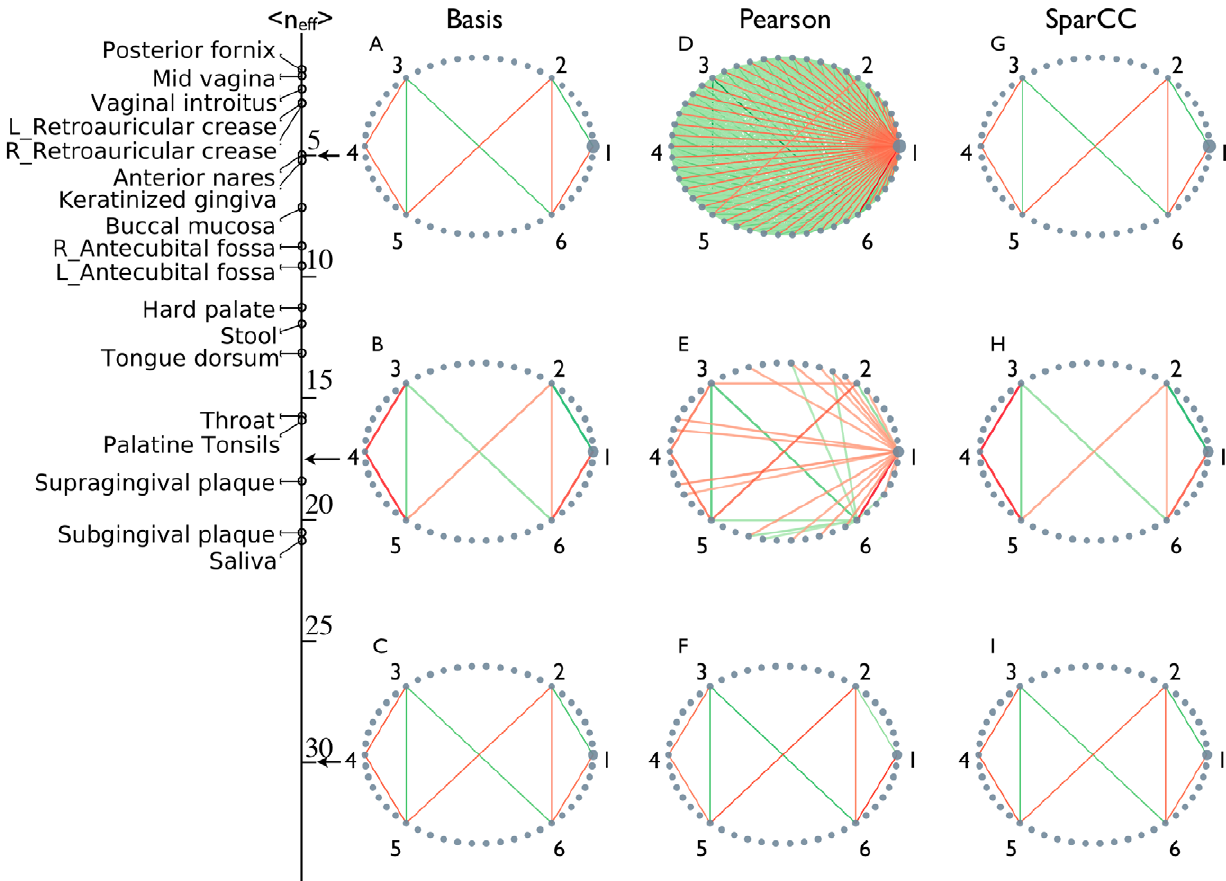
Figure 2. Pearson correlations inference quality deteriorates with decreasing diversity. Basis data was simulated with a known correlation structure. OTU counts were generated by randomly drawing from the basis, and were subsequently subject to both correlation inference procedures. (A–C) True basis correlation network. (D–F) Networks inferred using standard procedure. (G–I) Networks inferred using SparCC. The average community diversities, as given by the Shannon entropy effective number of components n eff , used in the simulations and observed in the HMP data are indicated on left indicates. As in Fig. 1, nodes represent OTUs, with size reflecting the OTU’s average fraction in the community. Nodes represent OTUs, with size reflecting the OTU’s average fraction in the community. Edges between nodes represent correlations between the nodes they connect, with edge width and shade indicating the correlation magnitude, and green and red colors indicating positive and negative correlations, respectively. For clarity, only edges corresponding to correlations whose magnitude is greater than 0.3 are drawn.